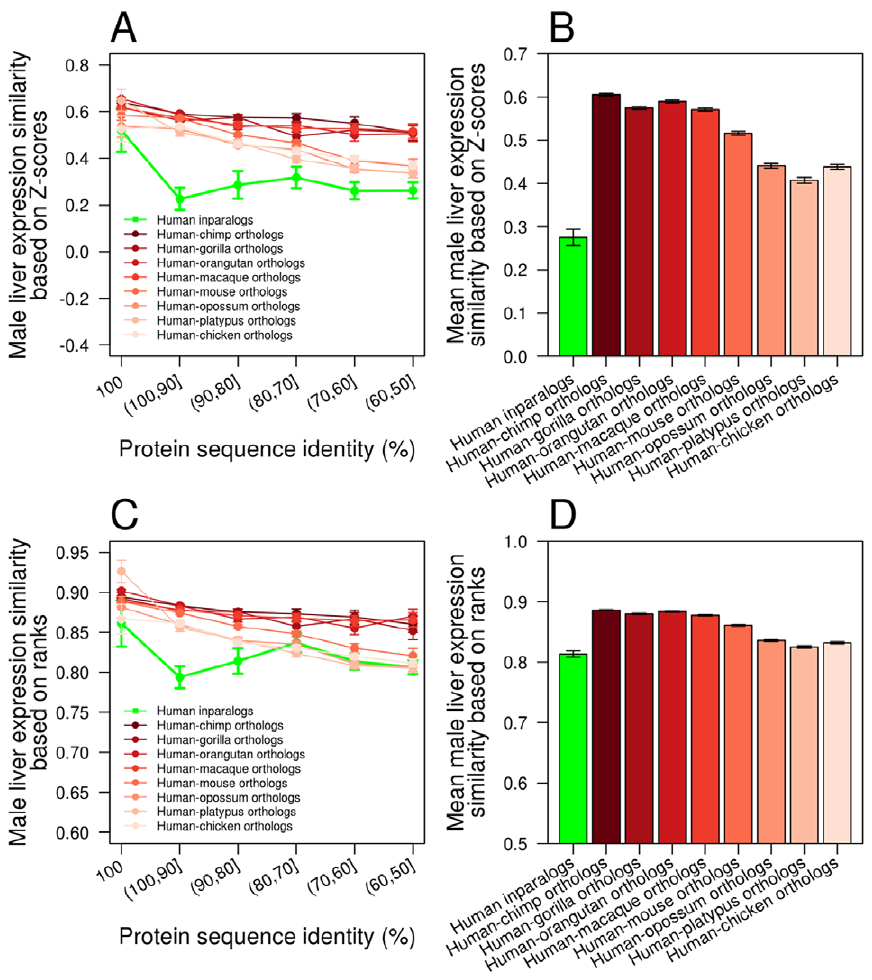
Figure 4. Male liver expression similarity of homologous genes from multiple species. ( A ) Z -score-based expression similarities of human inparalogs are lower than those of orthologs between human and multiple species, for all protein sequence identity bins. ( B ) Average Z -score-based expression similarity of human inparalogs and those of orthologs between human and multiple species. The green bar is significantly lower than each of the red bars ( P , 10 2 10 , two-tail Z -test). ( C ) Rank-based expression similarities of human inparalogs are lower than those of orthologs between human and multiple species, for most protein sequence identity bins. ( D ) Average rank-based expression similarity of human inparalogs and those of orthologs between human and multiple species. The green bar is significantly lower than each of the red bars ( P , 0.04, two-tail Z -test). For all panels, error bars indicate one standard error.